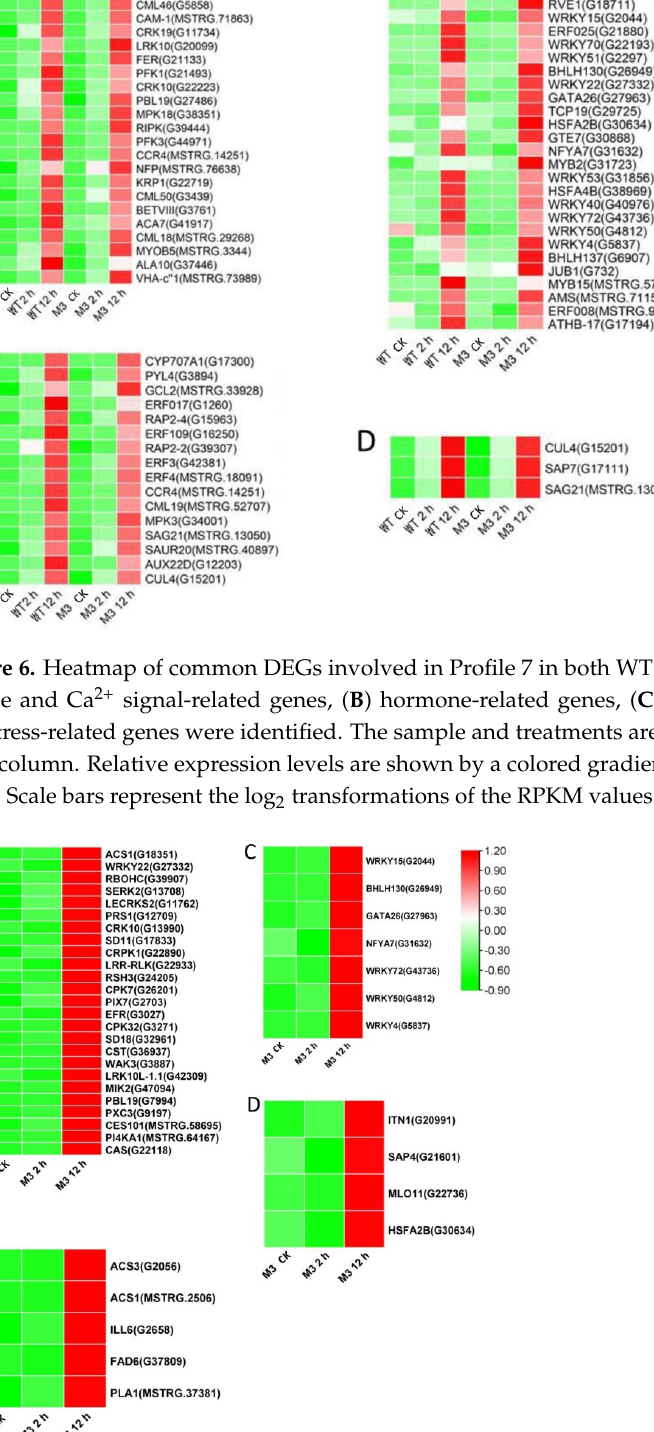
Figure 8. Heatmap of DEGs unique to M3 plants involved in Profile 7 in M3 plants. ( A ) Protein kinase and Ca 2+ signal-related genes, ( B ) hormone-related genes, ( C ) transcription factors, and ( D ) stress-related genes were identified. The sample and treatments are displayed at the bottom of each column. Relative expression levels are shown by a colored gradient, from low (green) to high (red). Scale bars represent the log 2 transformations of the RPKM values.